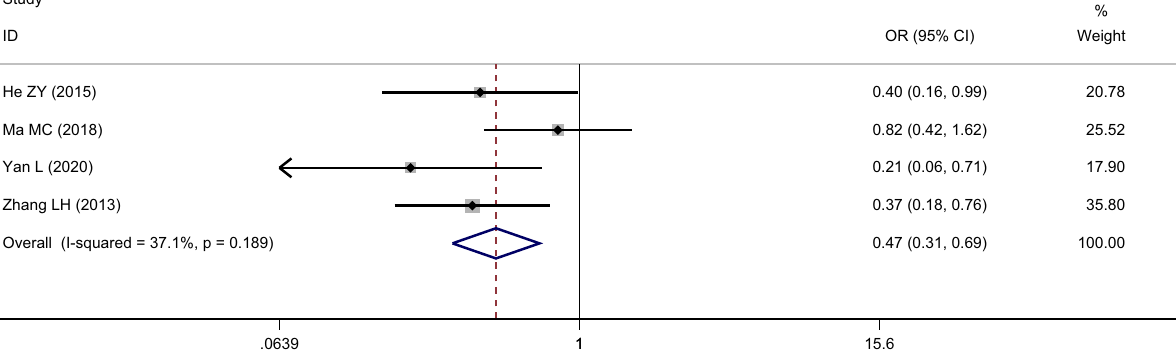
Overall (I-squared = 37.1%, p =